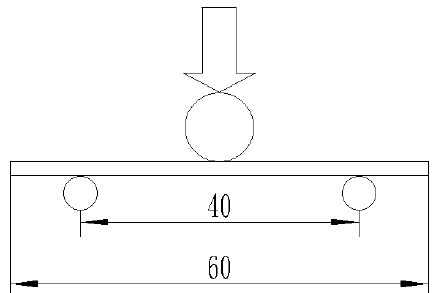
Figure 3. Scheme of the three-point flexural testing.